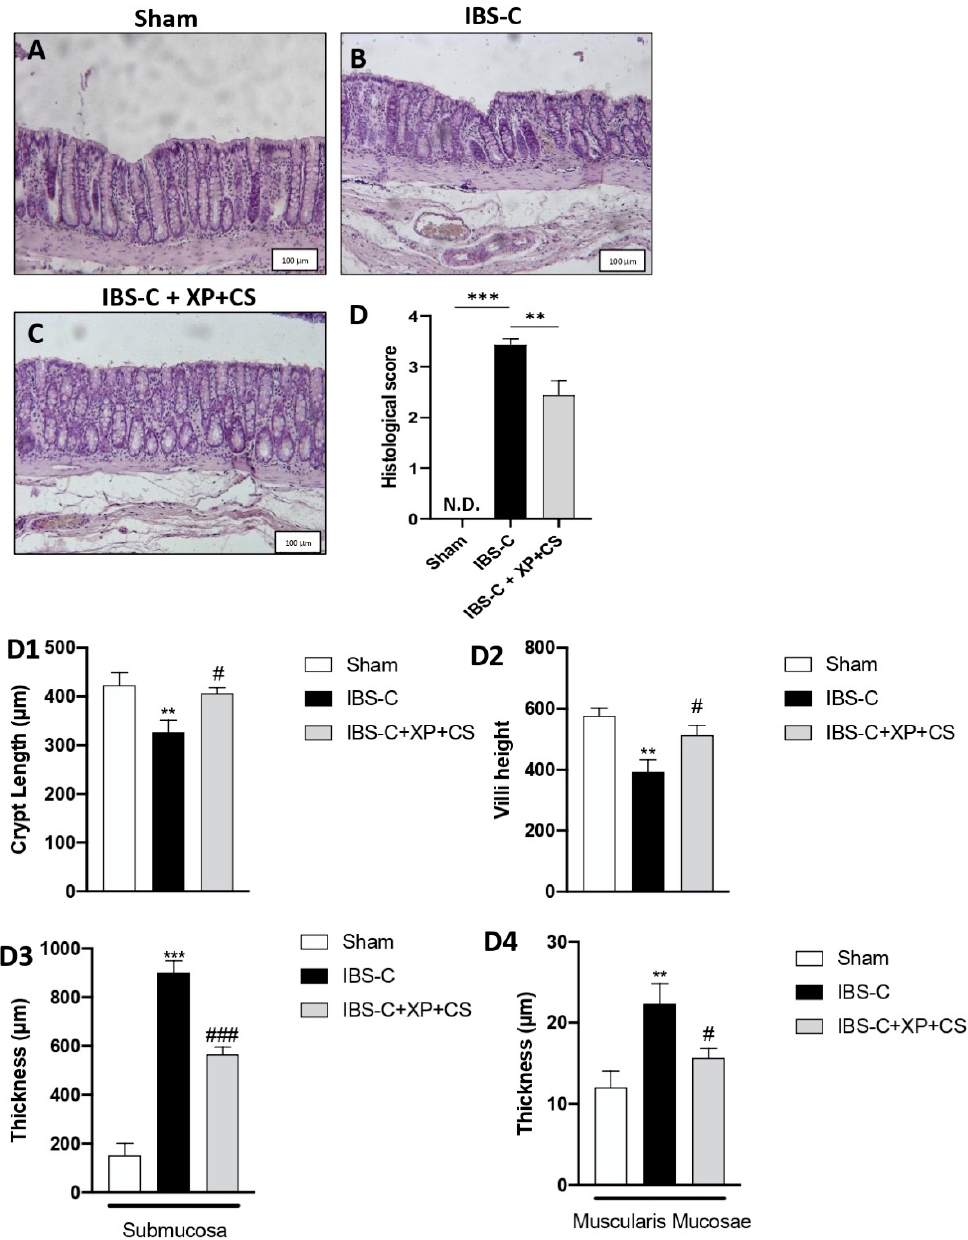
Figure 2. XP and CS treatment alleviate IBS constipation. Histological evaluation of colons at day 22. ( A ) Intact colon tissue from Sham group. ( B ) Colon tissue significantly damaged after IBS-C induction (IBS-C group). ( C ) XP + CS treatment alleviated colon damage after constipation (IBS-C + XP + CS group). ( D ) Histological score. ( D1 – D4 ) histomorphic parameters. *** p < 0.001 vs. Sham; ** p < 0.01 vs. Sham; ### p < 0.001 vs. IBS-C; # p < 0.005 vs. IBS-C; ND: not